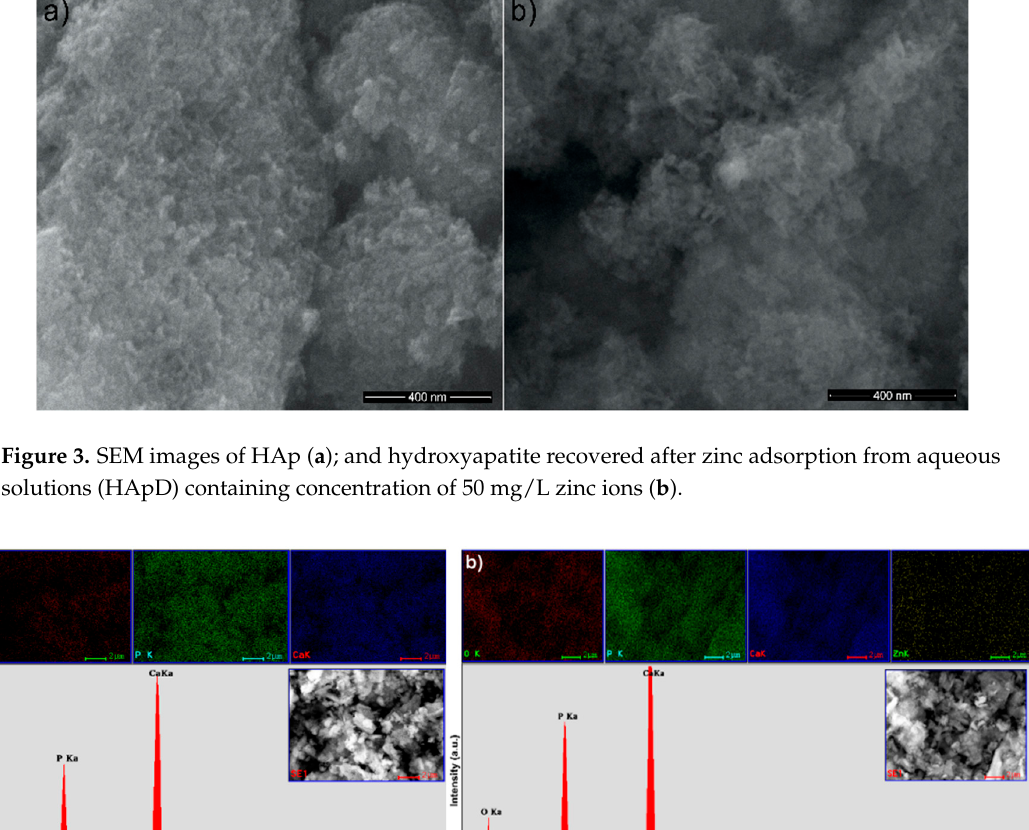
Figure 2. XRD patterns of hydroxyapatite (HAp) and hydroxyapatite recovered after zinc adsorption from aqueous solutions (HApD) containing concentration of 50 mg/L zinc ions. ( a ) 2 θ range of 25–55°; ( b ) 2 θ range of 25–27°.